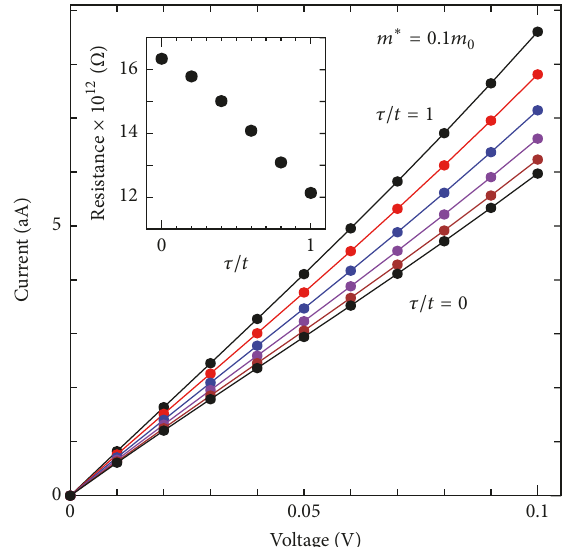
Figure 2: Current-voltage characteristics calculated for size of the conductor 𝑁 𝑑 = 20 and 𝑁 𝑤 = 10 and effective mass 𝑚 ∗ = 0.1𝑚 0 . The right inset shows schematic structure at the cathode-conductor interface where cross denotes the defect. The curves labeled “1,” “3,” and “5” denote current for a defect at the 1st, 3rd, and 5th rows in the interface, respectively. The left inset shows the resistance as a function of the defect position.